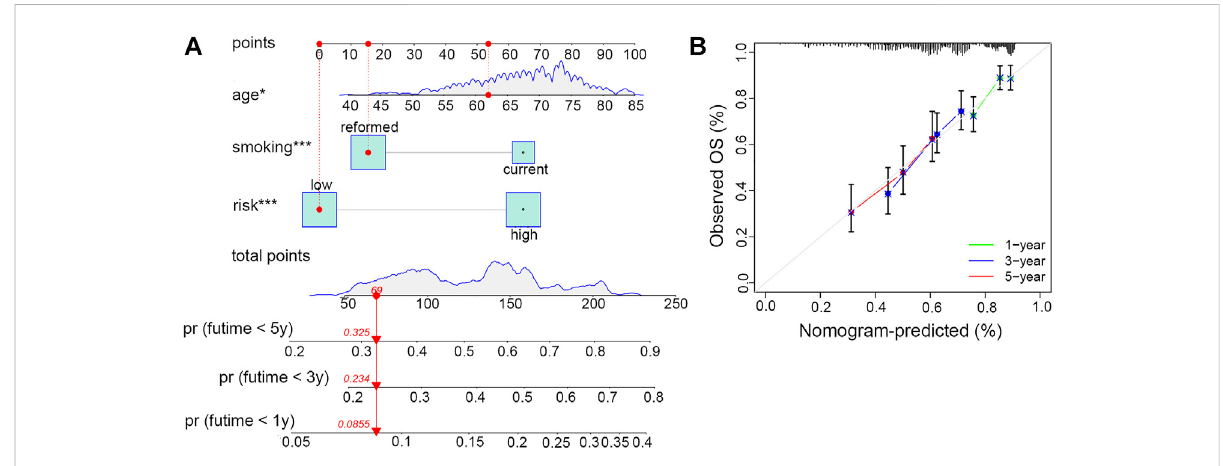
FIGURE 8 Establishment and evaluation of the clinical nomogram. (A) Nomogram to predict the survival possibility of smoking-associated LUSC patients at 1, 3, and 5 years. (B) Calibration curves to validate the prediction ef fi ciency of the nomogram at 1, 3, and 5